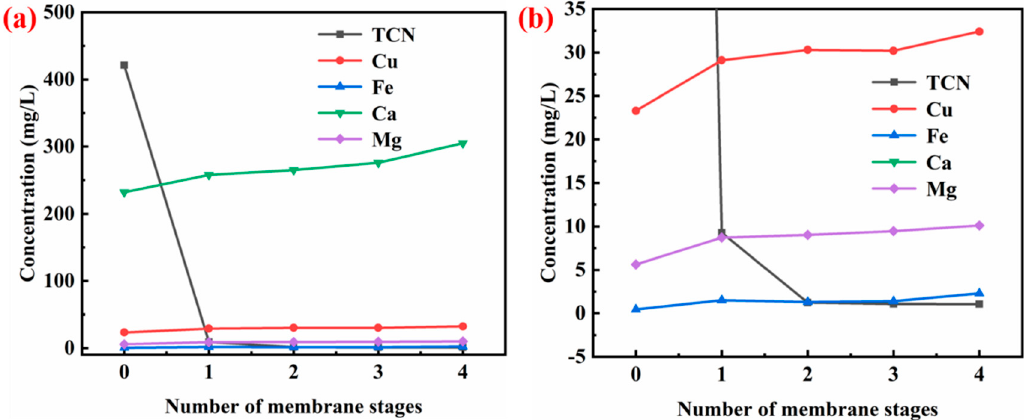
Figure 11. Effect of number of membrane stages on the membrane treatment process: ( a ) general view; ( b ) the range of − 5 to 35 mg/L in ( a ).